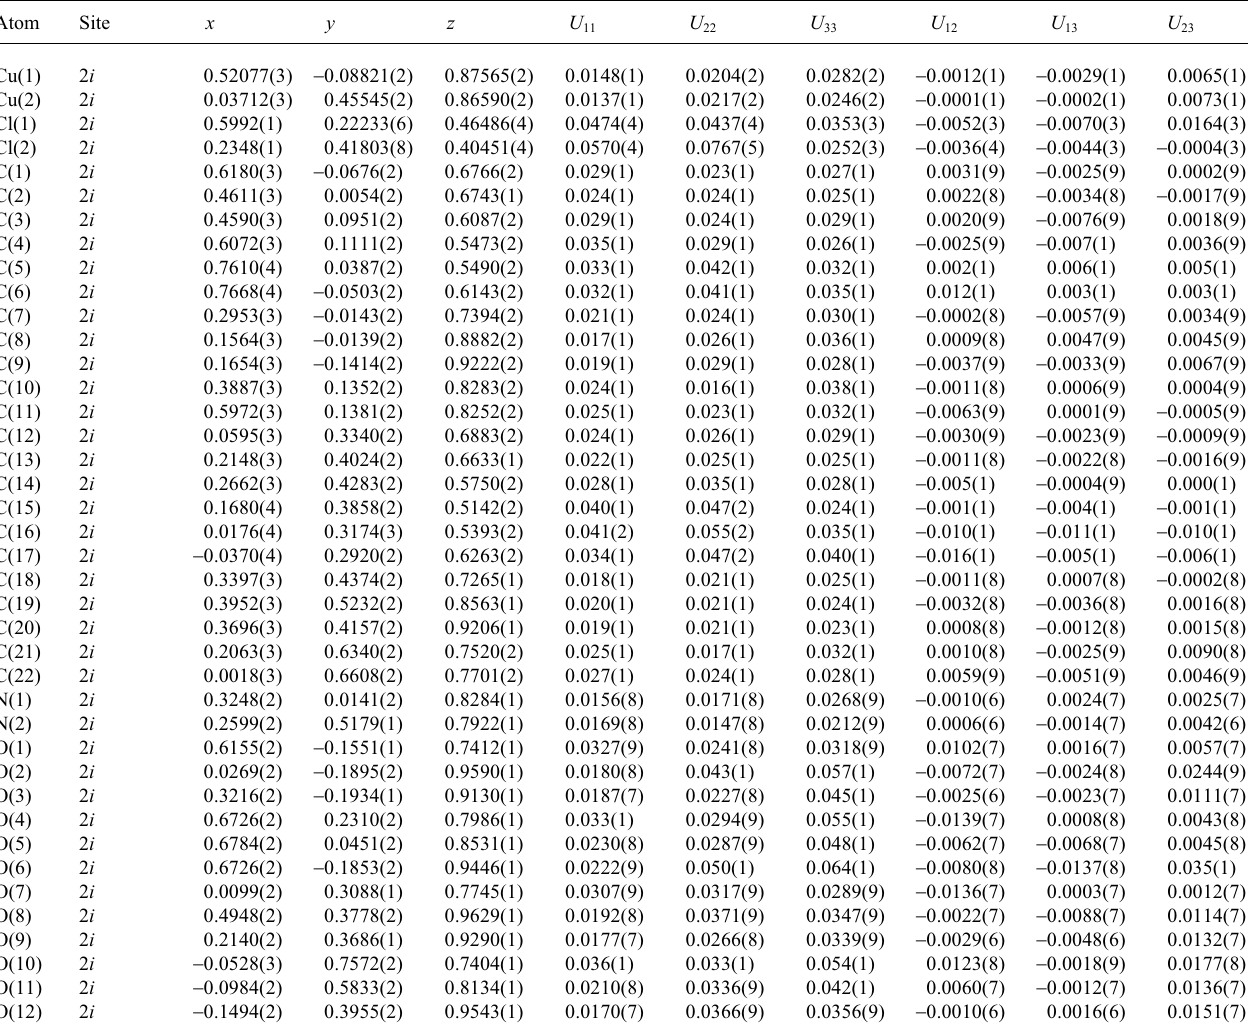
Table 3. Atomic coordinates and displacement parameters (in Å 2